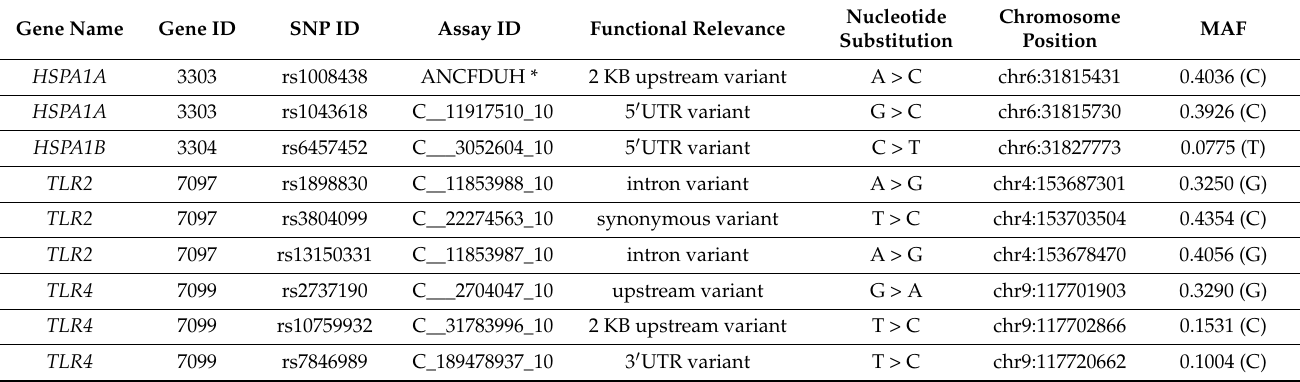
Table 1. Basic information about investigated polymorphisms in HSP70 , TLR2 and TLR4